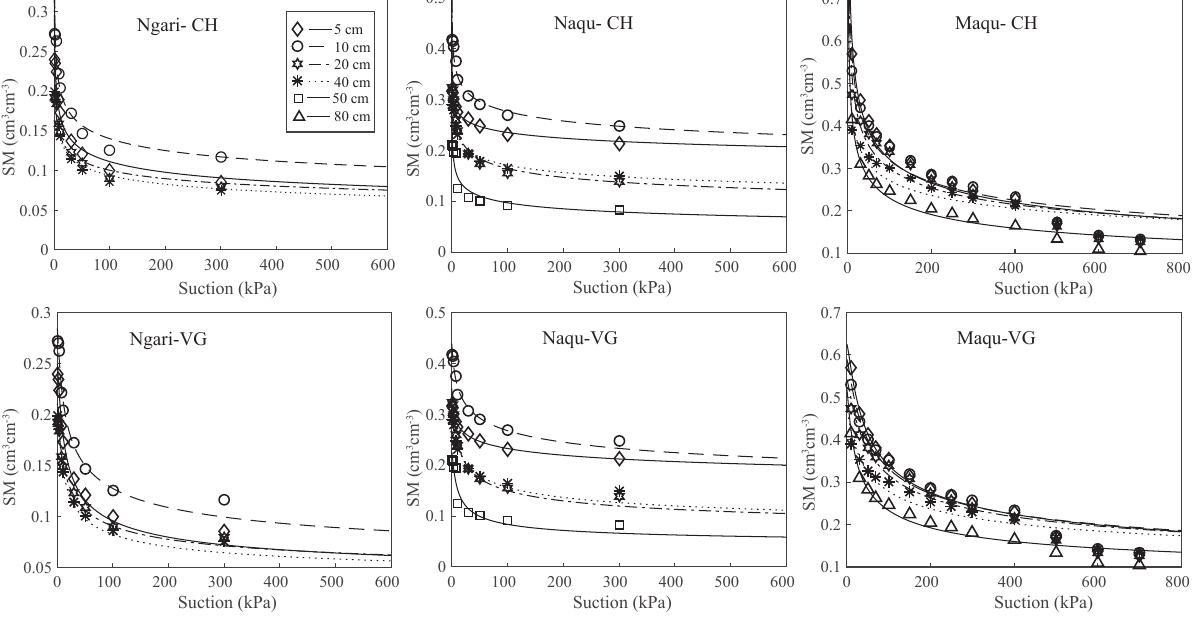
Figure 5. Average observational SWRCs and determined SWRCs–CH and SWRCs–VG from scaling method at different depths under the three climate zones: Ngari in the arid zone, Naqu in the semi-arid zone and Maqu in the subhumid zone. Dots denote average observed soil moisture content at specific suction. Lines represent determined SWRCs–CH and